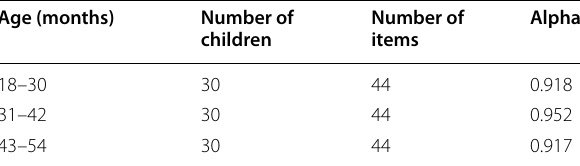
Table 7 Cronbach’s alpha coefficients for each age group Age